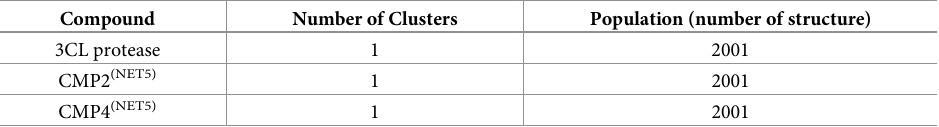
Table 6. Clustering result for last 20 ns time frame of MD Simulation for the top two hits and the native inhibitor of 3CL